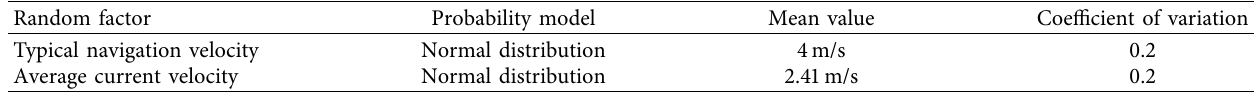
Table 2: Probability model and parameter value of random factors.